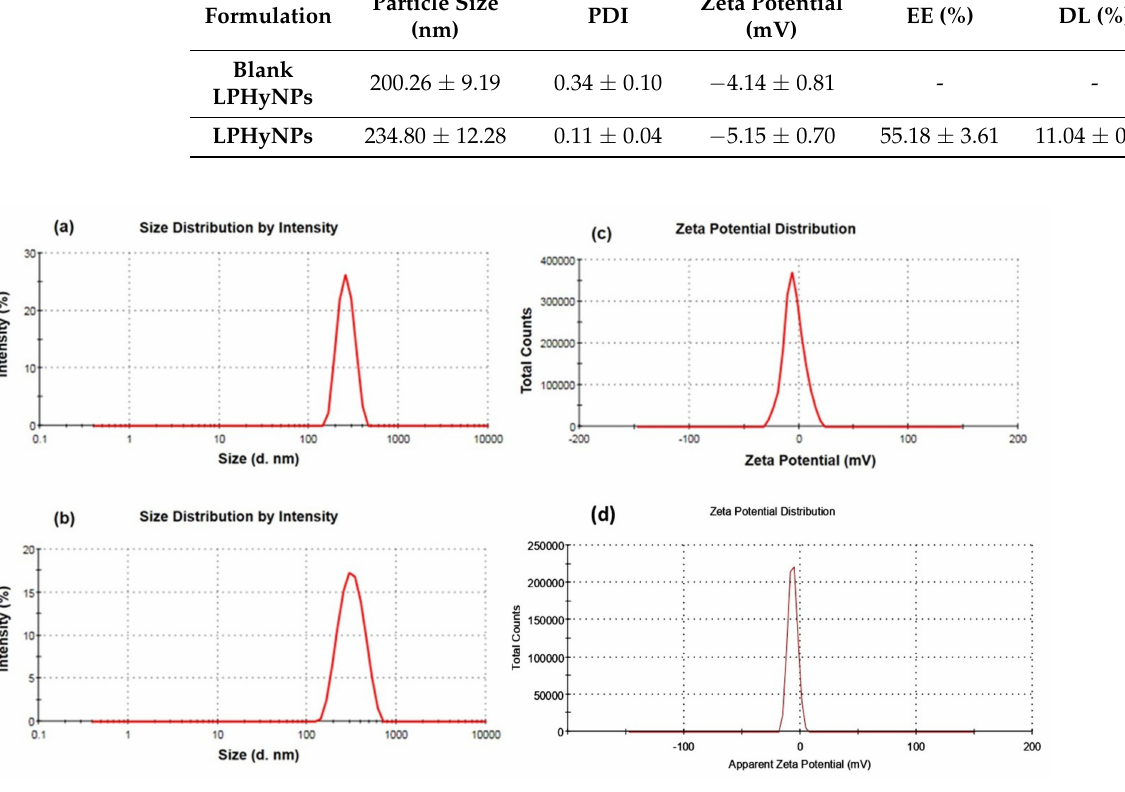
Figure 1. ( a , b ) Demonstrate particle size of blank LPHyNPs and drug-loaded LPHyNPs, and ( c , d ) show the zeta potential of blank LPHyNPs and drug-loaded LPHyNPs,